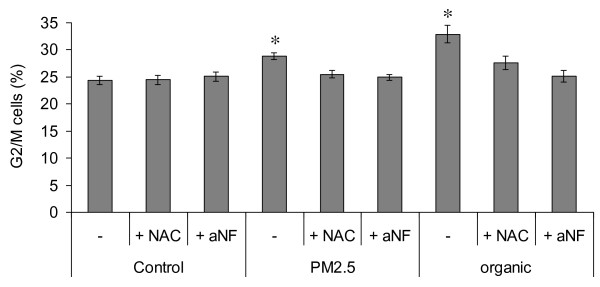
G2/M cells percentage. Cells percentage was assessed by cell cycle analysis of BEAS-2B cells exposed for 3 h to 7.5 μg/cm2 of whole-PM and organic fraction. NAC and α-NF were used to determine the role of ROS and CYP enzymes, respectively. * Statistically significant difference from control, P < 0.05. The results are representative of 3 independent experiments.